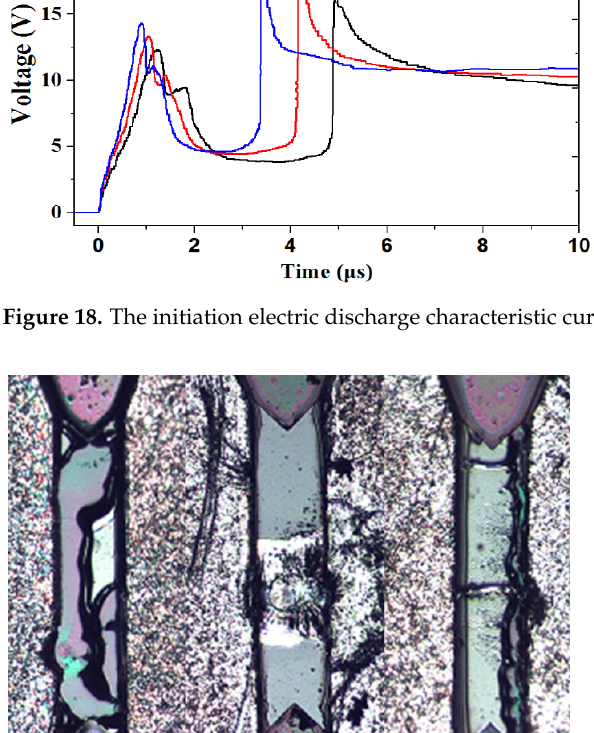
Figure 19. The result of LCEID with a different excitation voltage.